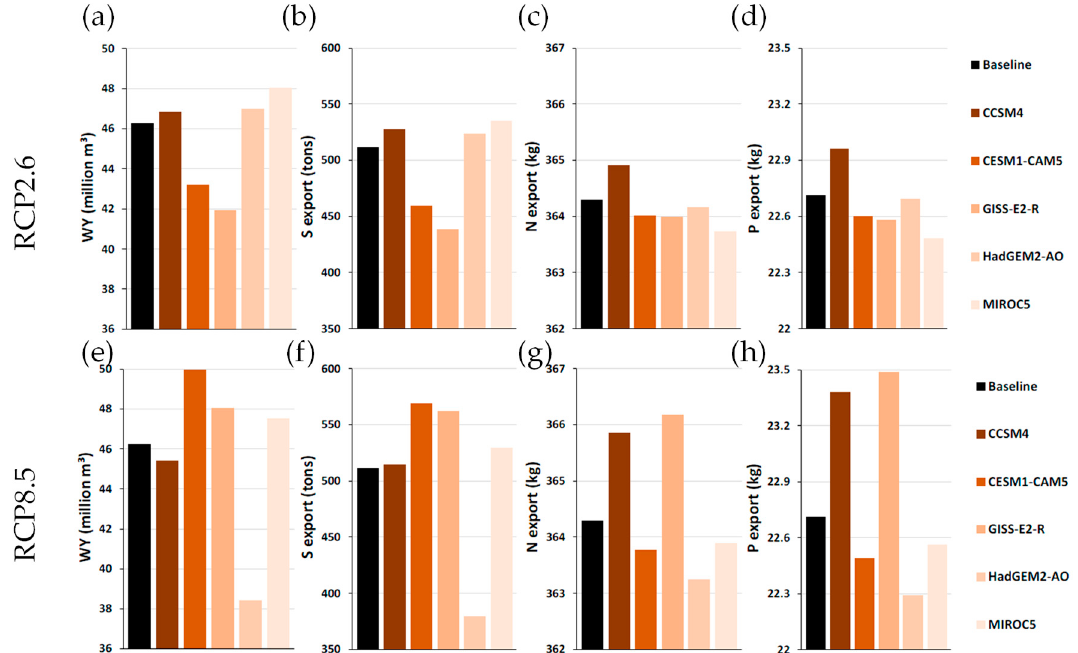
Figure 8. Four hydrologic ecosystem services, water yield ( a , e ), sediment export ( b , f ), N export ( c , g ) and P export ( d , h ) under RCP2.6 ( a – d ) and RCP8.5 ( e – h ) scenarios. Note: The six columns along the x-axis are the baseline and five general circulation models (GCMs), while the y-axis is the annual average output from